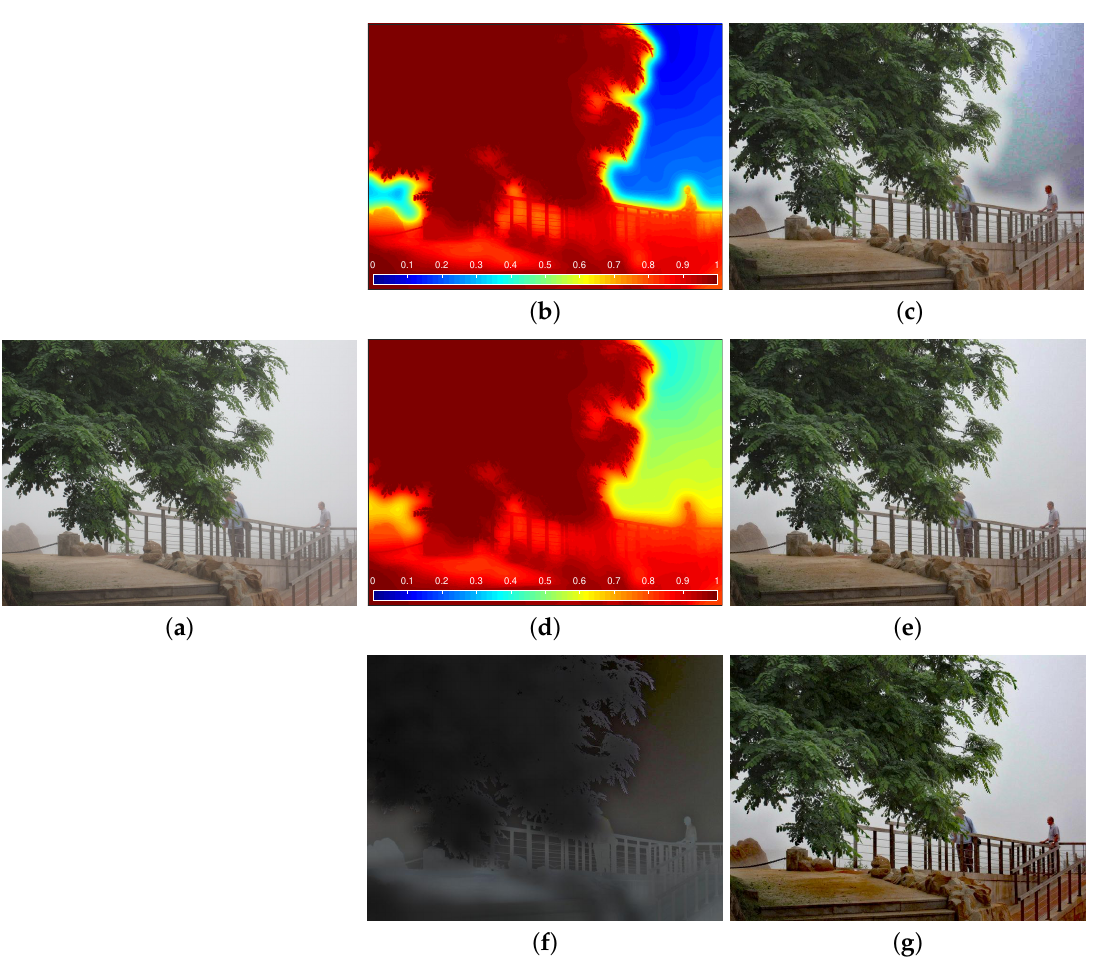
Figure 3. Dehazing example on a image with sky regions. ( a ) Hazy image; ( b ) the transmission of DCP; ( c ) the result of DCP; ( d ) our offset-corrected transmission; ( e ) our result with offset correction; ( f ) our weighted residual map; ( g ) our final